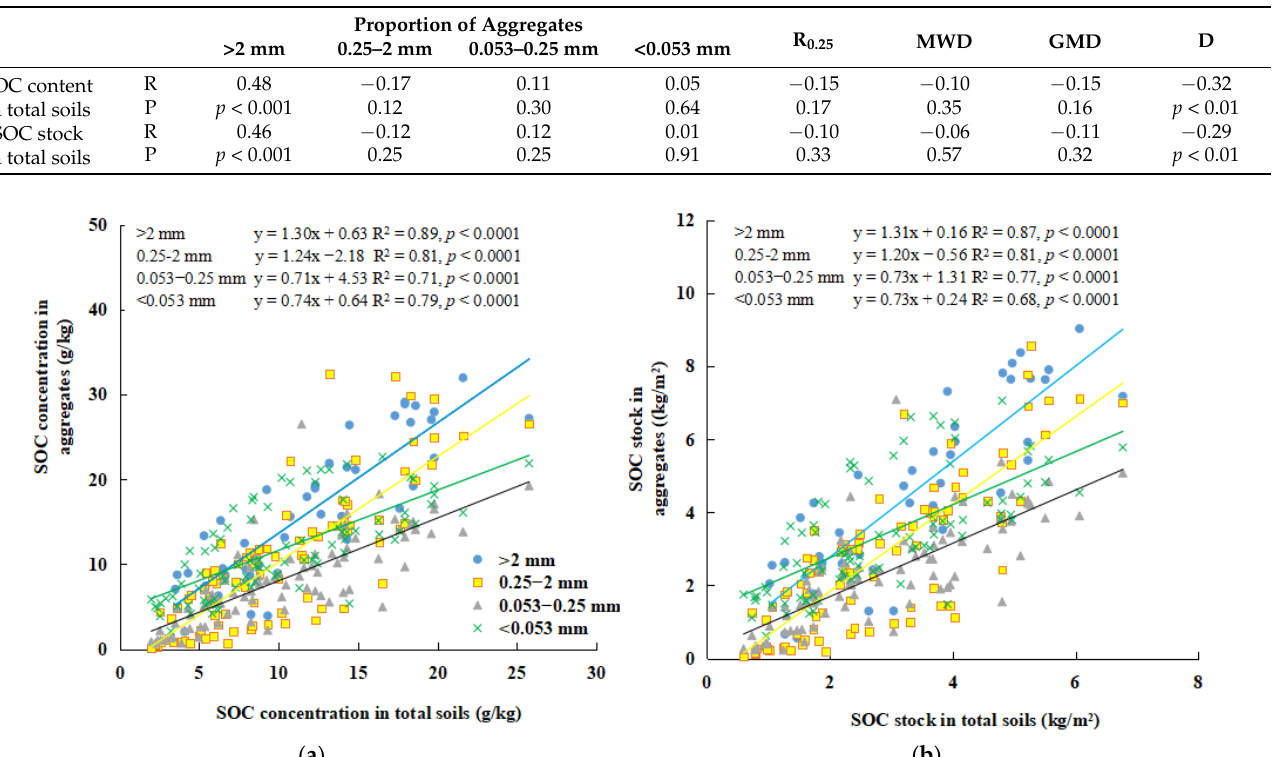
Table 2. Relationships between total SOC content (stock) and the distribution and stability param- eter of soil aggregates.